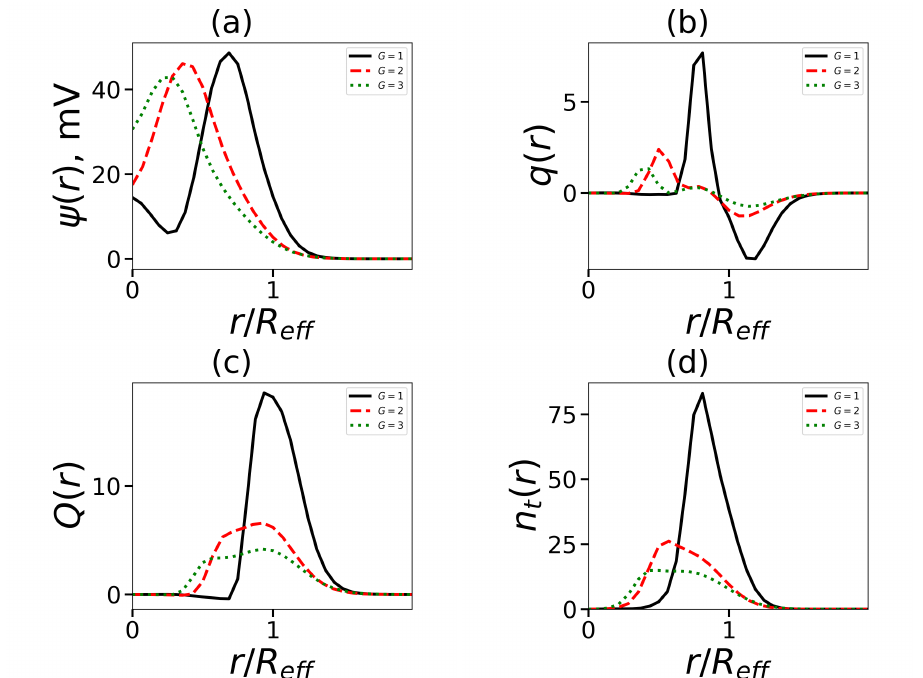
Figure 8. The normalized radial distribution (by effective radius R ef f , which is defined below) ( a ) the electrostatic potential ψ , ( b ) the dimensionless charge q ( r ) , ( c ) the cumulative charge Q ( r ) , and ( d ) the terminal charged groups of dendrons in the micelle. All cases correspond to the same number of tails t = 2, tail length N t =